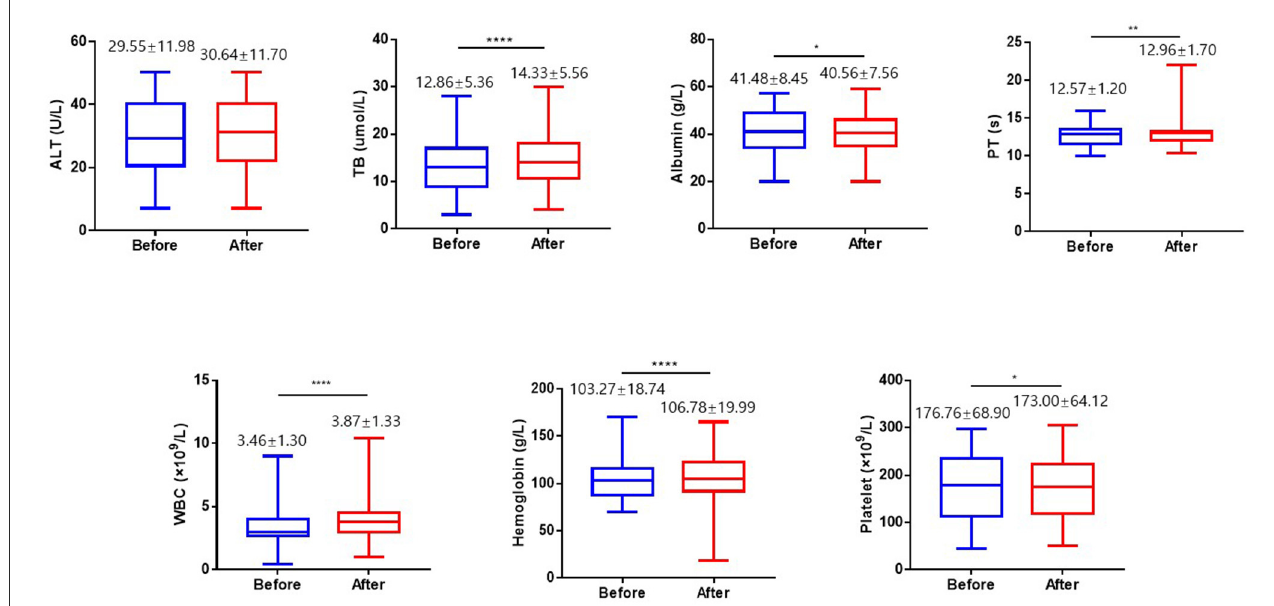
FIGURE1 The biochemical characteristics before and after vaccination. The serum levels of alanine amino transferase (ALT), total bilirubin (TB), and albumin were compared before and after vaccination. The value of prothrombin time (PT), the levels of white blood cell, hemoglobin and platelet in the blood were compared before and after vaccination. ALT, alanine amino transferase; TB, total bilirubin; PT, prothrombin time; WBC, white blood cell. * p < 0.05, ** p < 0.01, **** p < 0.0001.